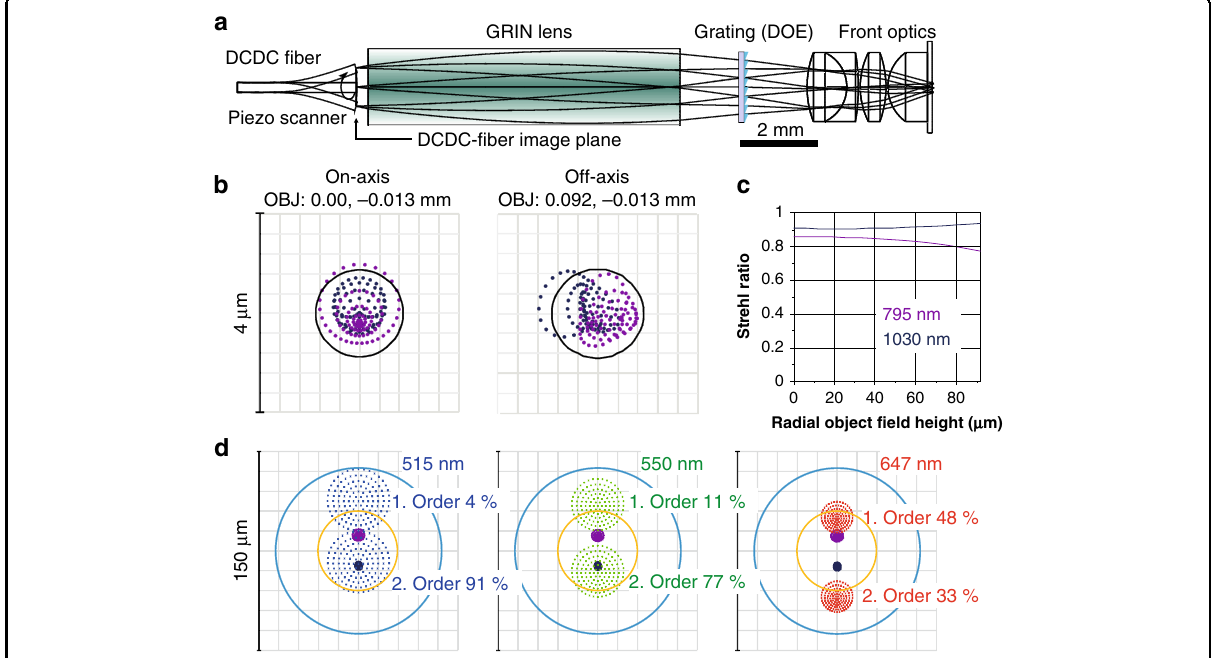
Fig. 3 Optical layout of the endomicroscopic objective and ray tracing results. a Design scheme of the endomicroscopic objective consisting of a resonant piezo-scanner guided DCDC fi ber, GRIN lens of 2.0 mm diameter, linear diffractive grating for combining pump and Stokes beam and front optics consisting of a refractive doublet and two singlet lenses, providing a numerical aperture of 0.55 at a working distance of 30 µm in water. The DCDC fi ber is scanned by a piezo tube resonant scanner in a spiral pattern at 1240 Hz resonance frequency. b Spot diagrams for the on-axis and off-axis fi eld positions for pump (795nm, purple) and Stokes laser (1030 nm, blue), the black circle shows the Airy disk (Airy radius 0.883 µm @ 795 nm) in the high NA object plane (NA = 0.55), simulated in ZEMAX. c Strehl ratio as a function of the fi eld height in the object plane for both, pump and Stokes wavelengths. The dashed line corresponds to a Strehl ratio of 0.8 indicating a diffraction-limited performance in the object plane. d Ray tracing spot diagrams in the DCDC fi ber image are shown for the fi rst two diffraction orders of the relevant signal wavelengths of 647 nm (CARS @ 2850 cm − 1 ), 515 nm (SHG from Stokes laser @ 1030 nm), and 550 nm (TPEF, spectral range 525.5 – 630.5 nm). The objective design allows to cover the ray bundles of both diffraction orders for all three signals by the two diameters, 60 and 125 µm, of the collection cladding of the fi ber (yellow and blue circle), assuming ideal point sources with NA = 0.55 as origins in the object plane. The percentage values given are calculated diffraction ef fi ciencies of an ideal blazed grating pro fi le with a Blaze wavelength of 927 nm, which is optimized for the pump and Stokes laser 34